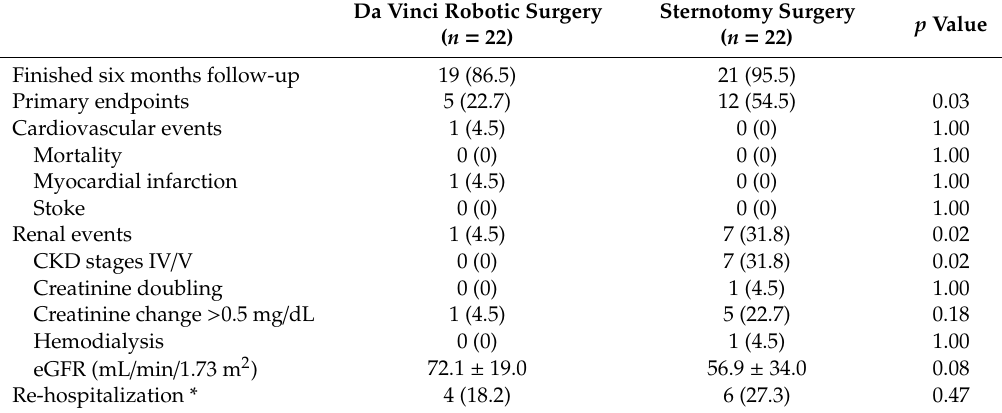
Table 3. Clinical outcomes at six months between two surgical